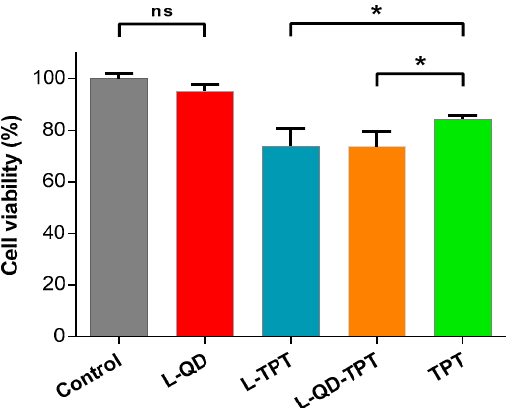
Figure 5. Cytotoxicity of the liposomal formulations and free TPT on HeLa cells. Cells were incubated with, L–QD, L–TPT, L–QD–TPT and free TPT (equivalent concentration of loaded TPT, 2.0 µ g/mL) for 24 h. 3-(4,5-Dimethylthiazol-2-yl)-2,5-diphenyltetrazolium bromide (MTT) assay was applied. Error bars represent the standard deviation from the mean ( n = 3). Data were analyzed using t -test, and * p < 0.05 was considered significant. ns: not significant.